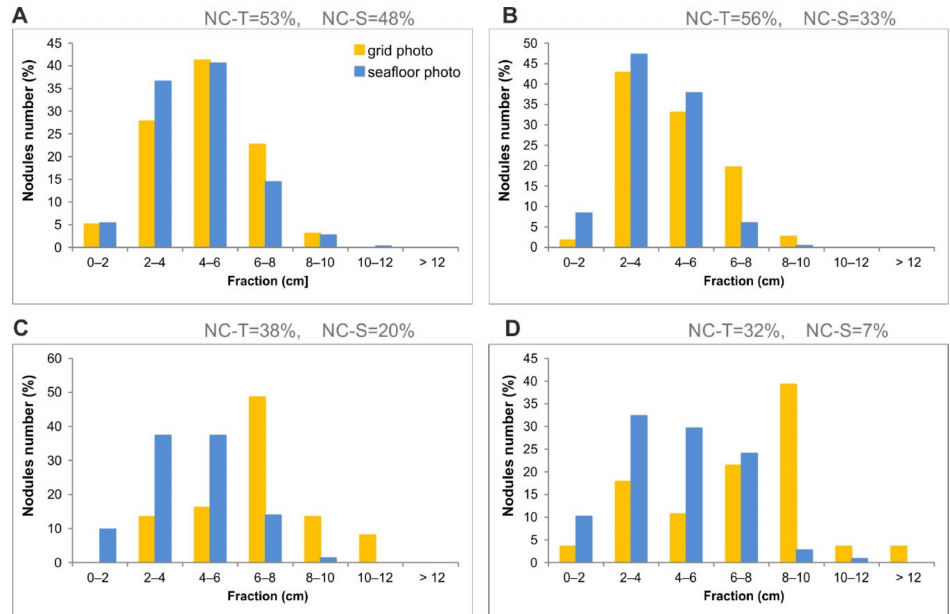
Figure 6. Examples of di ff erences in the distributions of nodule fractions in the grid and seafloor photographs for 4 di ff erent degrees of nodule coverage with sediments (see photographs in Figure 5); NC-T—nodule coverage of grid, NC-S—seafloor nodule coverage. ( A )—low coverage (1), ( B )—medium